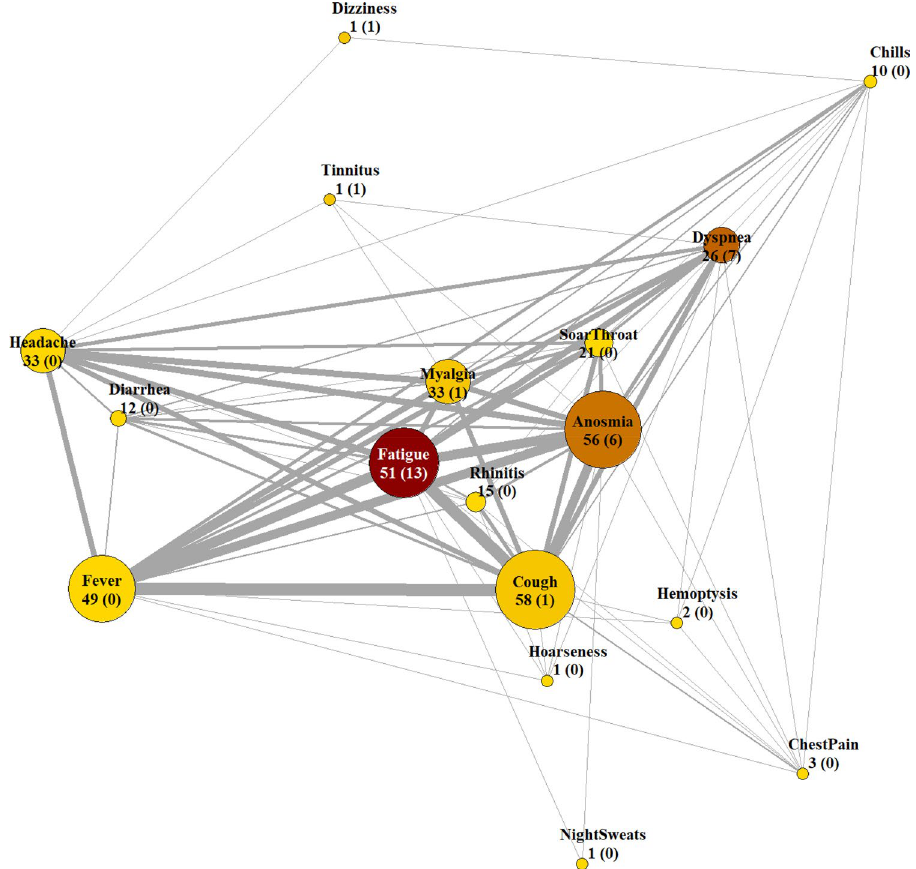
Figure 3. Network analyses of symptom nodes. Node size and node number correspond to the number of patients having that onset symptom. The number in parentheses corresponds to persistent symptoms, which is also indicated by the redness of the symptom node. Thickness of grey edges corresponds co-occurrence of onset